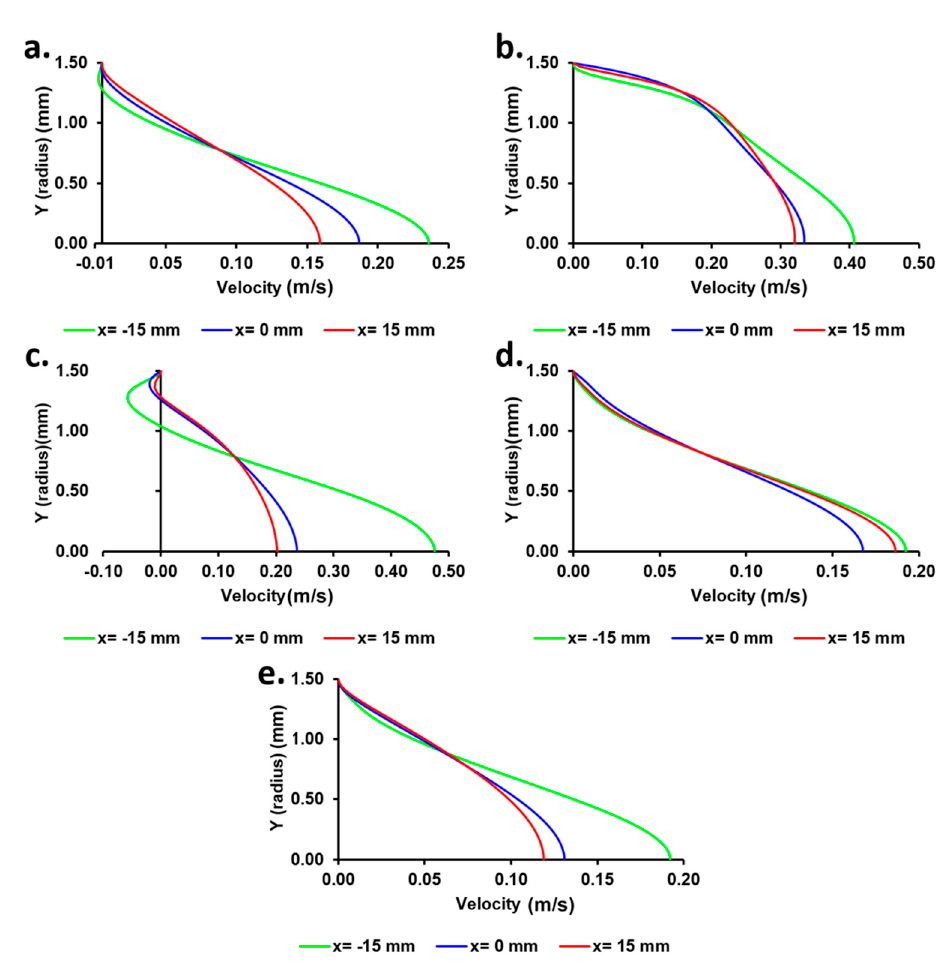
Figure 16. Local velocity profiles for selected time steps on phases I and II at the inlet (x = − 15 mm), the middle (x = 0 mm) and the outlet (x = 15 mm) of the vascular graft region for ( a ) t = 0.585s, ( b ) t = 0.63s, ( c ) t = 0.675 s, ( d ) t = 0.855 s, and ( e ) t = 0.99 s.